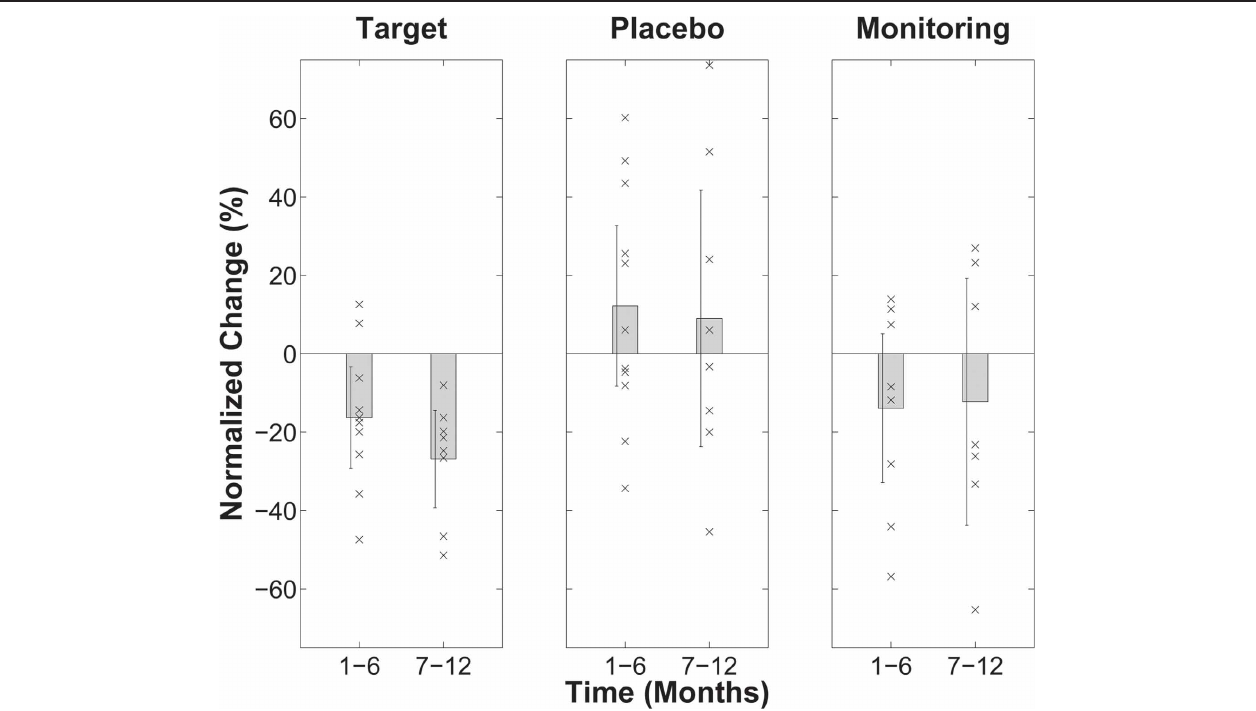
FIGURE 8 | ( Modified from Okamoto et al., 2010a,b ) Normalized tinnitus loudness change after 6 and 12 months of treatment (or monitoring) relative to baseline ( = 0) for the three patient groups (target TMNMT, placebo TMNMT, and monitoring). Positive change values reflect